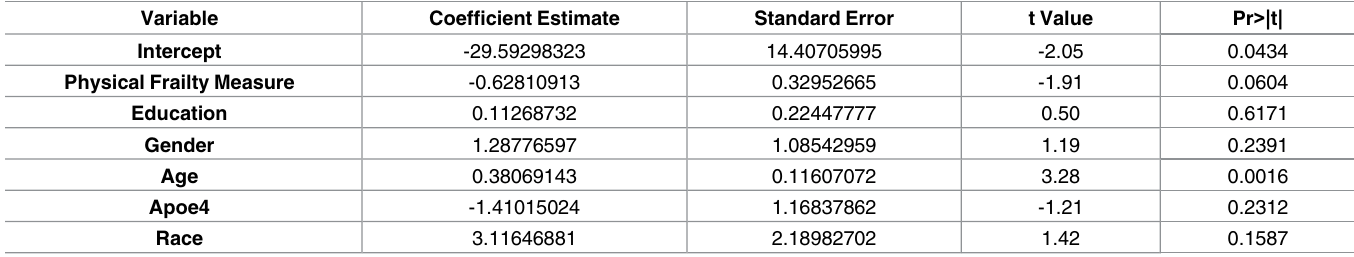
Table 3. Regression Analysis of Physical Frailty Measure with Road Test Total Error Count.